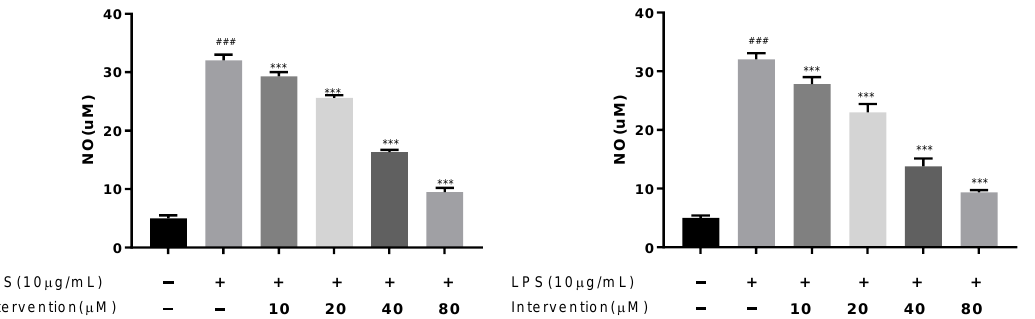
Figure 4. The NO inhibitory activity of compounds 1 and 2 in LPS-activated RAW264.7 cells. ### p < 0.001 vs. control group, *** p < 0.001 vs. LPS group ( n = 3).